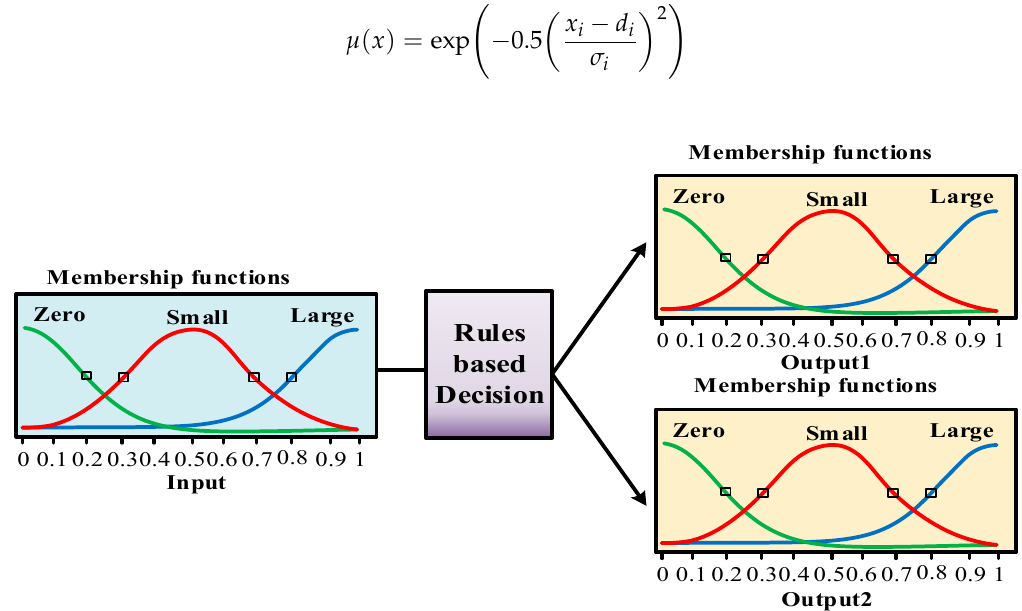
Figure 5. Output–input membership functions.